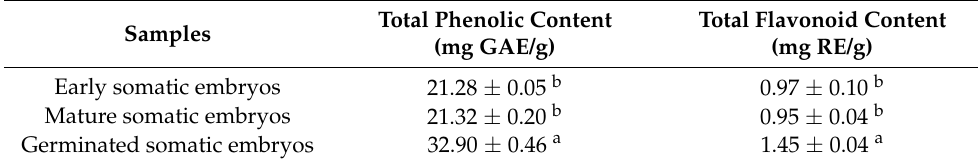
Table 3. Total phenolic and flavonoid contents of the tested